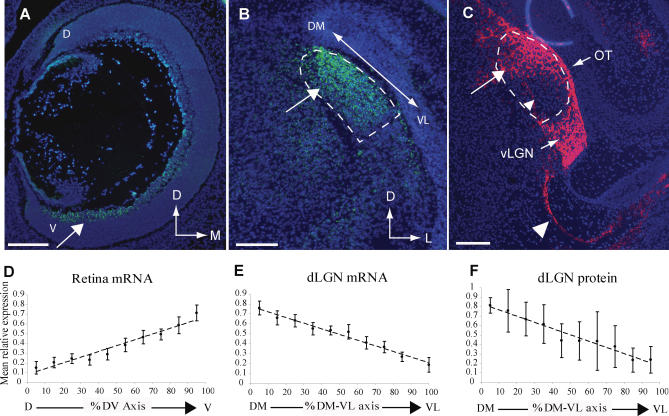
Expression of Ten_m3 in Developing Visual PathwayThe expression of Ten_m3 is shown using in situ hybridisation (A) and (B) or immunohistochemistry (C).(A) Coronal section through the retina at E16. Ten_m3 is highly expressed in the retinal ganglion cell layer where it is highest in ventral retina (arrow).(B) Coronal section through the dLGN at P0. Ten_m3 is expressed high dorsally (arrow) and low ventrally.(C) Coronal section through the dLGN showing immunoreactivity for Ten_m3. Expression is highest in the dorsal region of the nucleus (arrow). High expression is also seen laterally in the optic tract (OT) and in the vLGN. Expression is also visible in fine fascicles traversing the nucleus (small arrowhead) and in larger bundles that appear to be heading to and/or from the internal capsule (large arrowhead). The dashed line delineates the boundaries of the dLGN in (B) and (C). Orientations are as indicated. D, dorsal; L, lateral; M, medial. Scale bars indicate 100 μm.(D–F) Graphs plotting relative Ten_m3 expression at P0–2. Ten_m3 mRNA is graded across the dorsoventral axis of the retina (D) and the DM-VL axis of the dLGN ([E] DM-VL axis illustrated by the double-headed arrow in [B]). Expression levels of Ten_m3 protein (F) are also graded along the DM-VL axis of the dLGN.